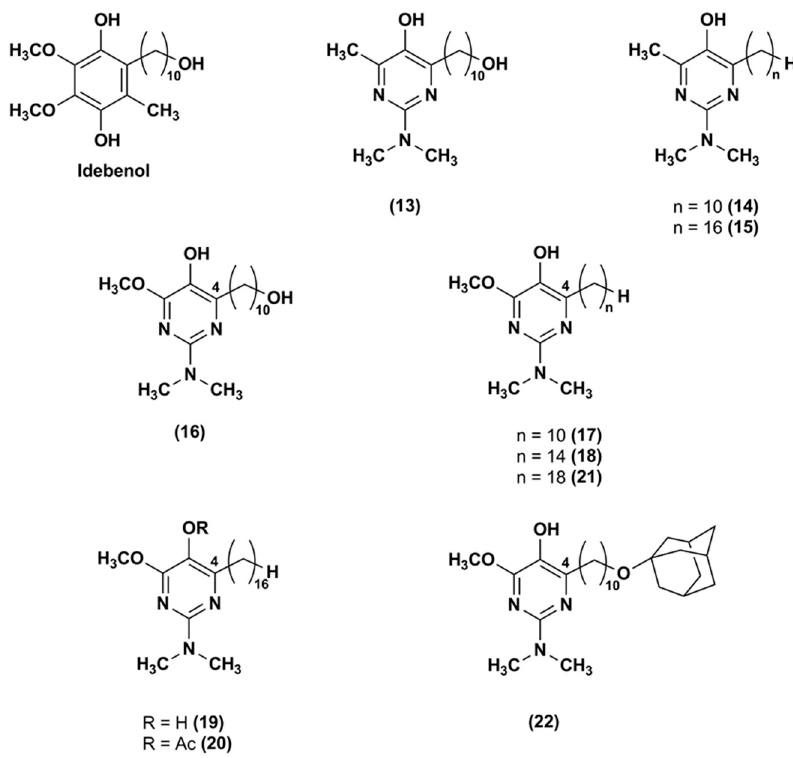
Figure 4. Chemical structures of the IDE aza-analogues.